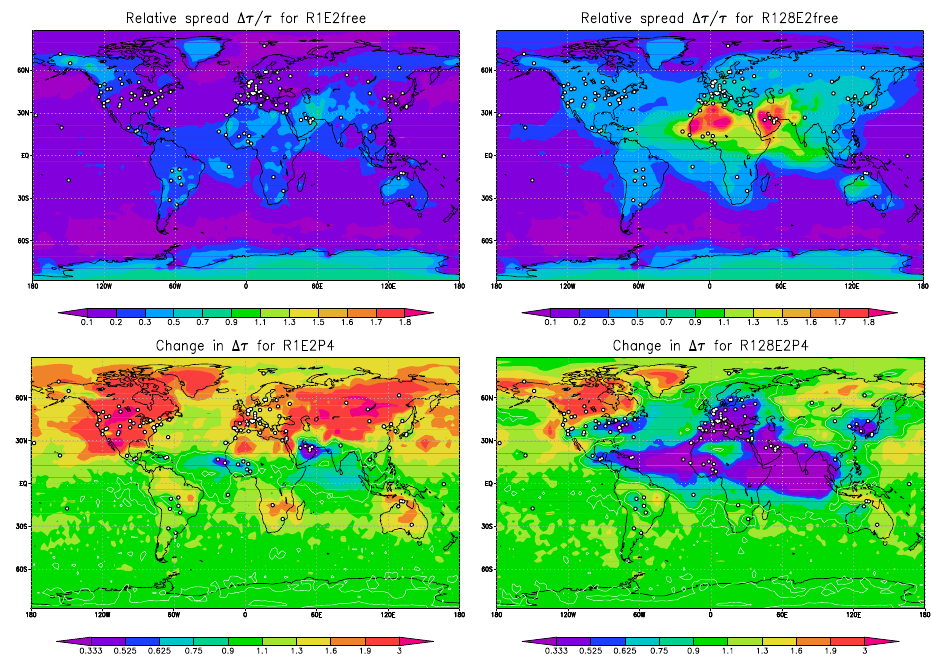
Fig. 23. Top panels show the relative ensemble spread in AOT for the n reg = 1 and 128 free run experiments. Bottom panels shows the ratio of ensemble spread in AOT for the baseline and free run experiments. The white line is the contour of value 1 (indentical spread).